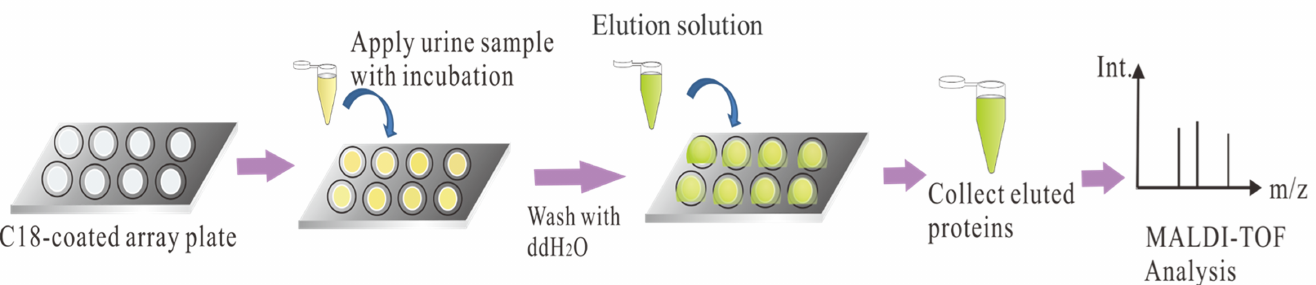
Fig 1. Analytical flowchart of urinary proteins by C18 plate-MALDI-TOF approach. Urine samples were from healthy, DM-WNP, DM-NP or WDM-NP subjects.